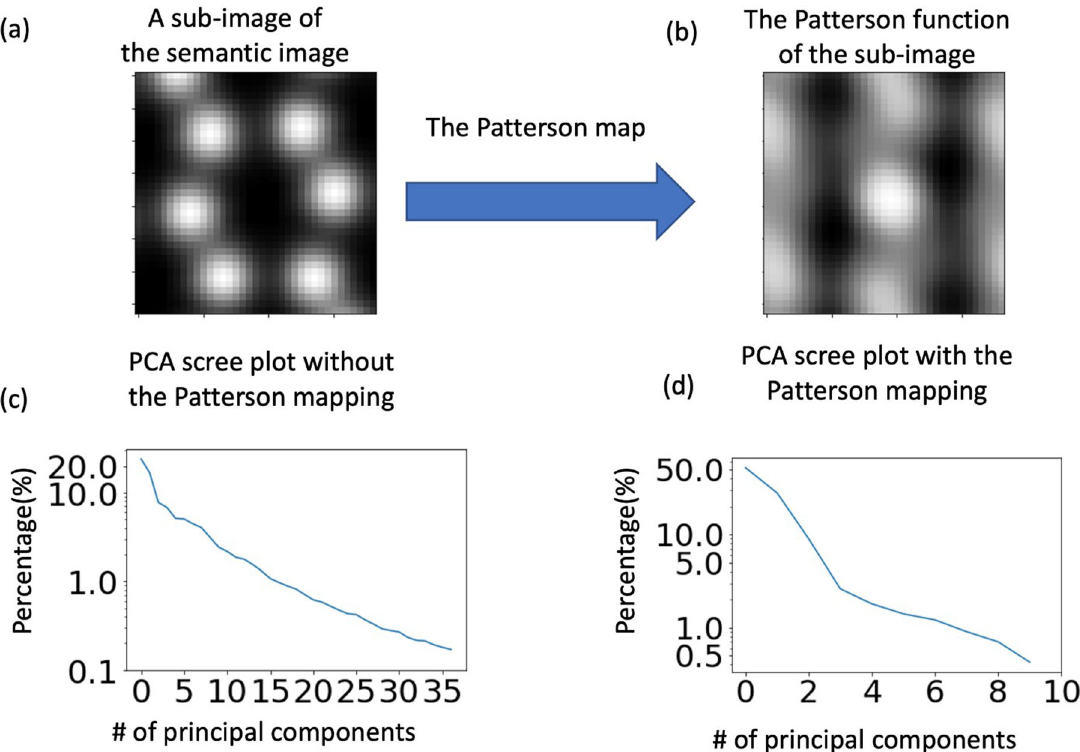
Fig. 2 Illustration of how Patterson mapping can greatly reduce the effect of arbitrary shifts in the fi rst demonstration. a Subimage of atom-coordinate image (Fig. 1d) where unit cell is not well centered and b Patterson function of the subimage, where Patterson function is always centrosymmetric. PCA is performed on two datasets, one consisting of subimages like in a and the other consists of Patterson maps like in b . PCA scree plots without c and with d Patterson mapping plotted on a logarithmic scale. PCA scree plot shows how much each principal component accounts for covariance of data matrix (the size for the fl attened vector for each image × the number of images). c The explained variance (%) drops slowly and 36 principal components are needed to account for 98% of the covariance of data matrix. d The explained variance (%) drops more rapidly than that in c and only 9 principal components are needed to account for 98%. This comparison shows that the highly dispersive covariance in c , caused by arbitrary shifts, is greatly reduced by the Patterson